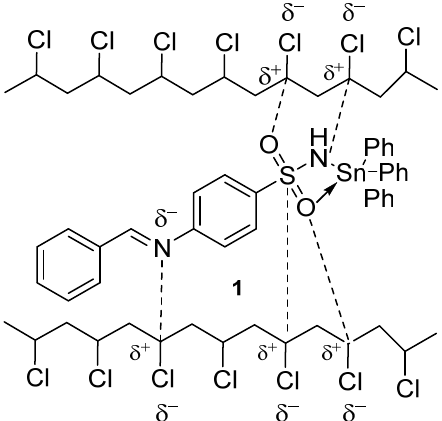
Figure 12. Interaction between complex Ph3SnL and PVC.